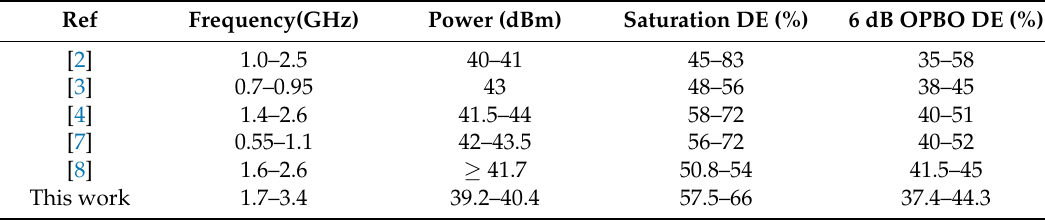
Table 2. Performance